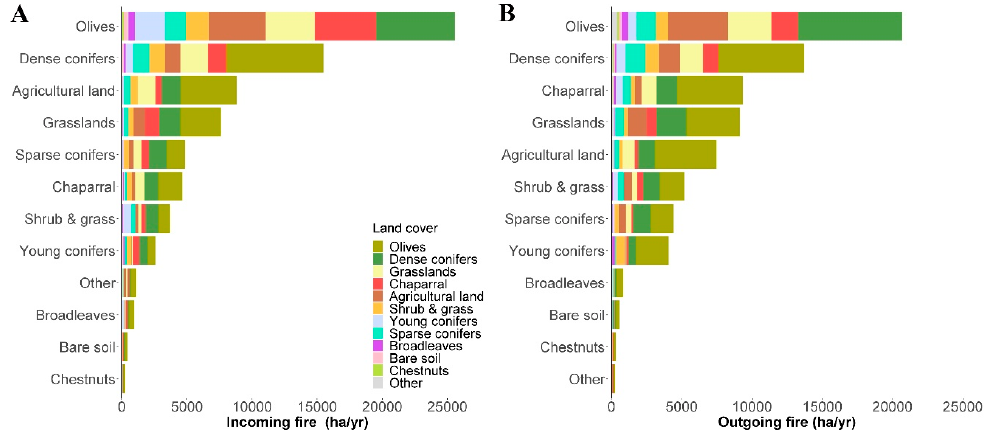
Figure 5. ( A ) Predicted annual area burned from fires ignited elsewhere by source of ignition (bar colors indicate fire source); ( B ) Outgoing area burned on other land cover types ( y -axis labels indicate fire source; bar colors indicate recipient of fire).